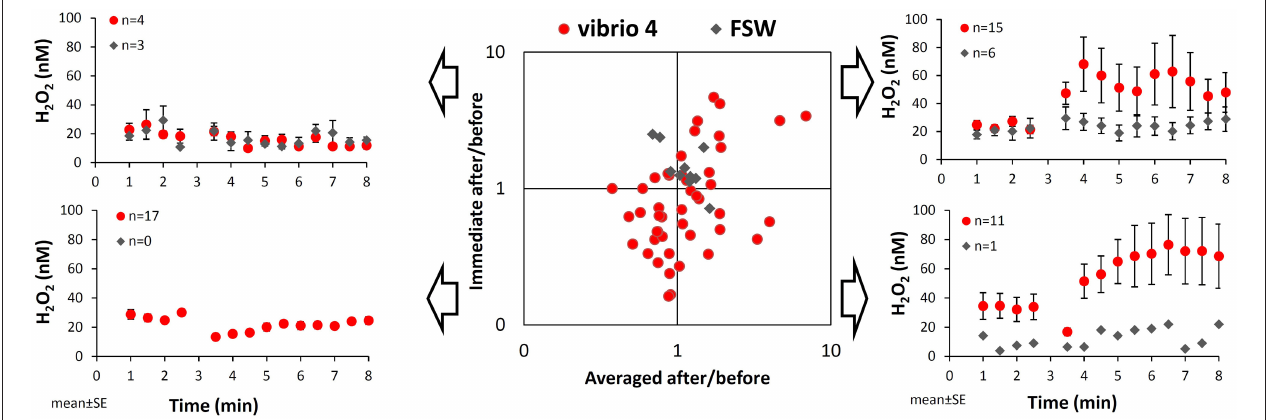
FIGURE 2 | Variations among individual experiments in the pattern of H 2 O 2 release from Stylophora pistillata following interaction with Vibrio . Taking a closer look at the changes in H 2 O 2 concentrations over time in individual experiments we noted four distinct patterns, which are illustrated on the side panels. The scatter plot conveniently distinguishes between these patterns according to the ratio of H 2 O 2 concentrations after and before the interaction with bacteria. These ratios are calculated separately for mean changes in H 2 O 2 concentrations (x-axis) or for immediate changes in H 2 O 2 concentrations (y-axis; i.e., at 3.5 min over 2.5 min). Here, values below 1 represent a drop in H 2 O 2 concentrations following interaction, while values above 1 represent an increase in H 2 O 2 concentrations. The red dots are all 48 experiments conducted with Vibrio 4 and the gray diamonds are the 10 seawater controls.